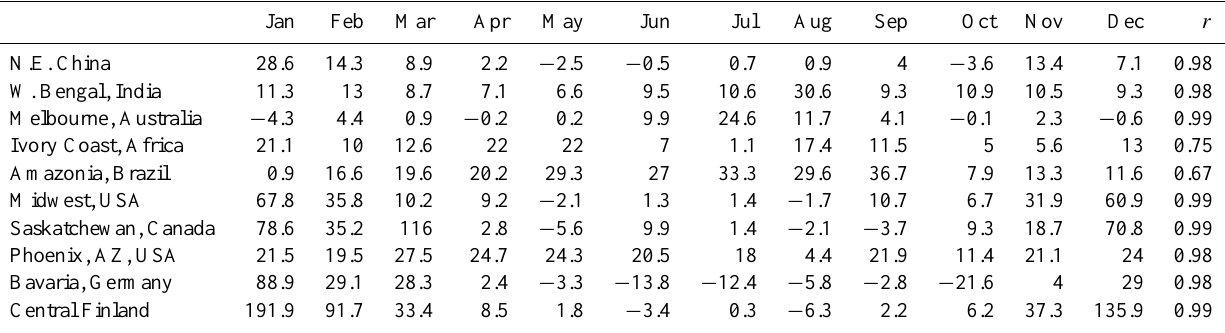
Table 2. The “all-sky” monthly mean incoming solar surface flux ( R s ) of the Simple model relative to DISORT (shown as % deviation from DISORT). Correlation coefficients ( r) are also presented.